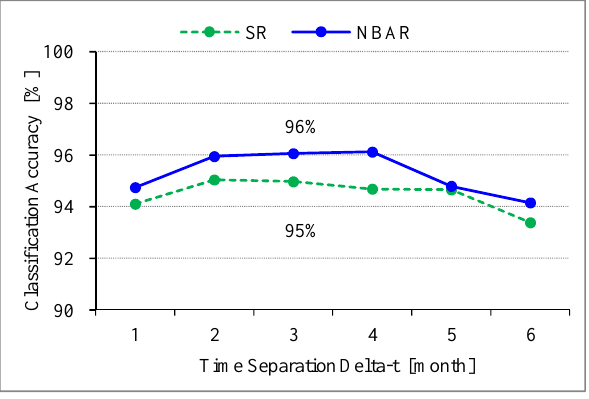
Figure 7. Classification accuracies obtained by time-domain co-occurrence matrix which is defined with reflectance.